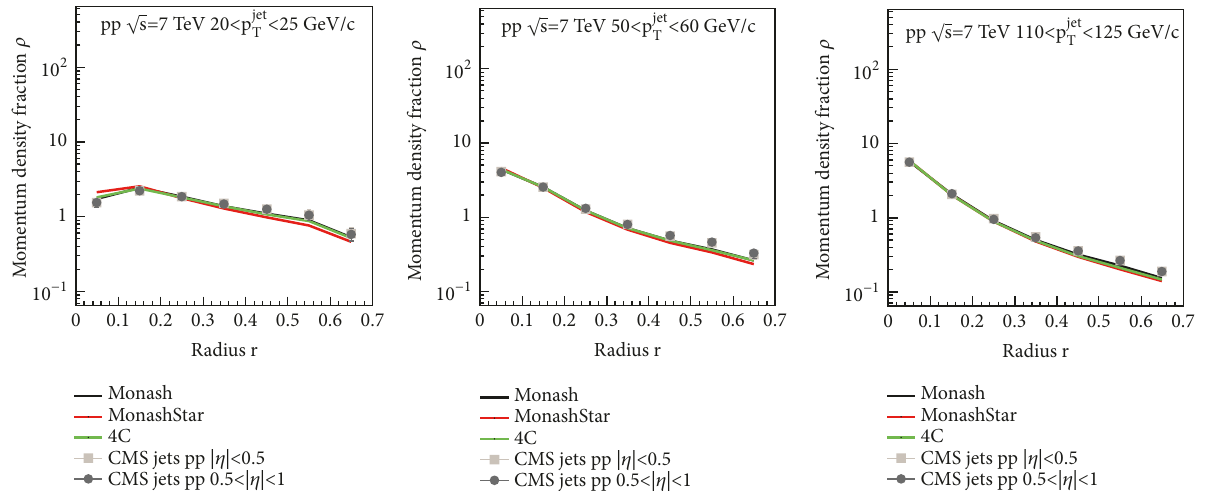
Figure 1: Differential jet structure 𝜌(𝑟) measured by the CMS experiment in pp collisions at √𝑠 = 7 TeV [18], compared to different PYTHIA < 25 GeV/ 𝑐 (left) , 50 GeV /𝑐 < 𝑝 jet < 60 GeV /𝑐 (center) and 110 GeV /𝑐 < 𝑝 jet tunes, for 20 GeV /𝑐 < 𝑝 jet T T